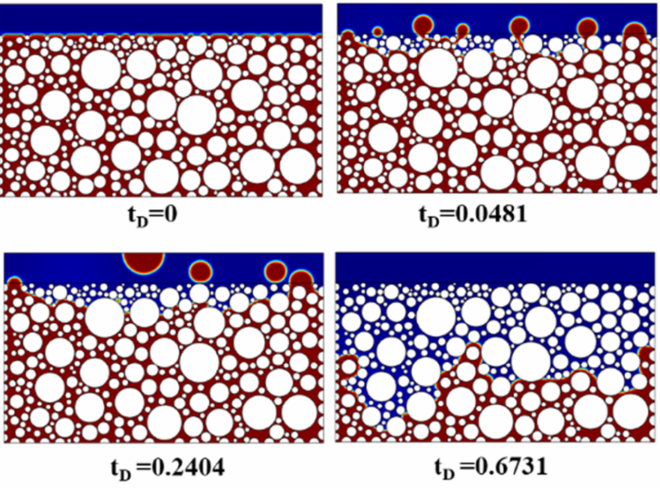
Figure 11. Oil-water distribution at different times.